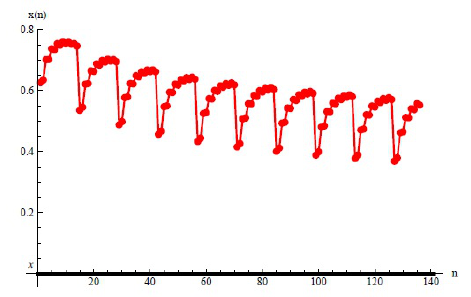
Fig. 1 x n graph of the